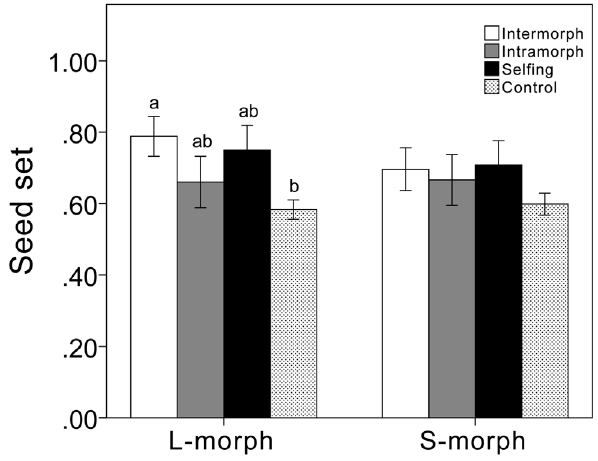
Figure 6 – Differences of seed set (mean ± SE) of four hand- pollination treatments in L-morph and S-morph flowers. Different letters indicate significant differences between the means under Tukey HSD multiple comparisons (P <